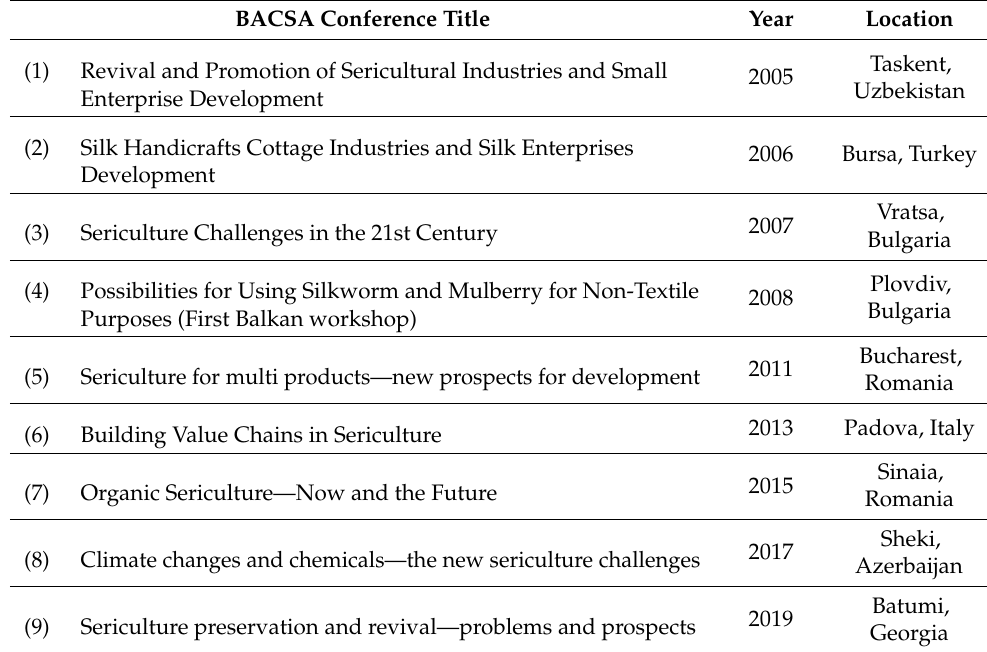
Table 1. BACSA conferences